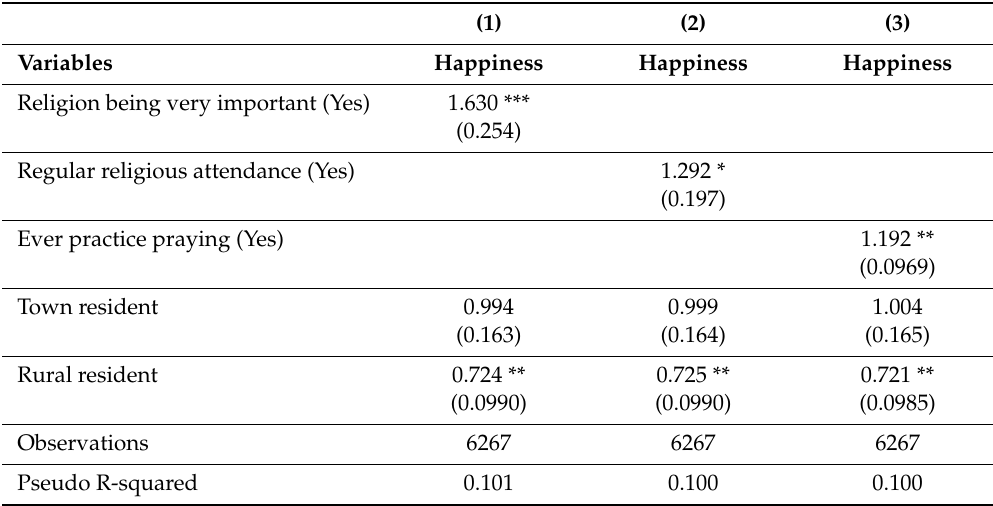
Table 3. The association between religiosity / religious practices and happiness (ordered logistic model, odds ratios